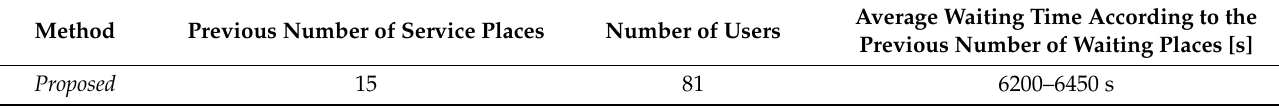
Table 6. The average waiting time when the number of users is increased from 75 to 81, and the service capacity remains the